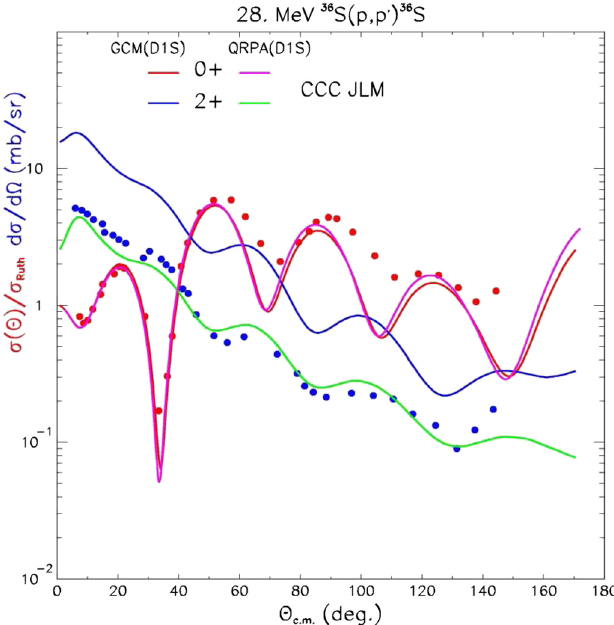
Fig. 3. (p,p 0 ) angular distribution on 36 S for the ground state and fi rst 2 + state using two microscopic structure approaches (GCM or QRPA see text for details) to determine transition densities required for a coupled channel calculation within the semi- microscopic JLM approach.